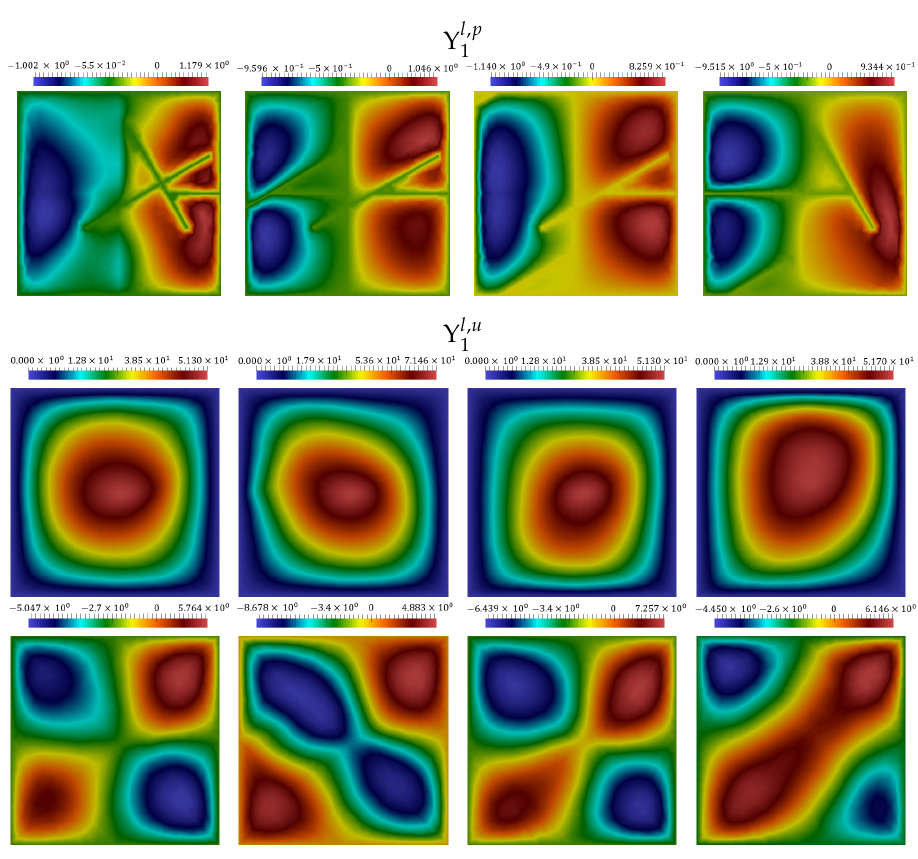
Figure 6. An example of four online multiscale basis functions for pressure and displacement in X and Y directions for local domains with